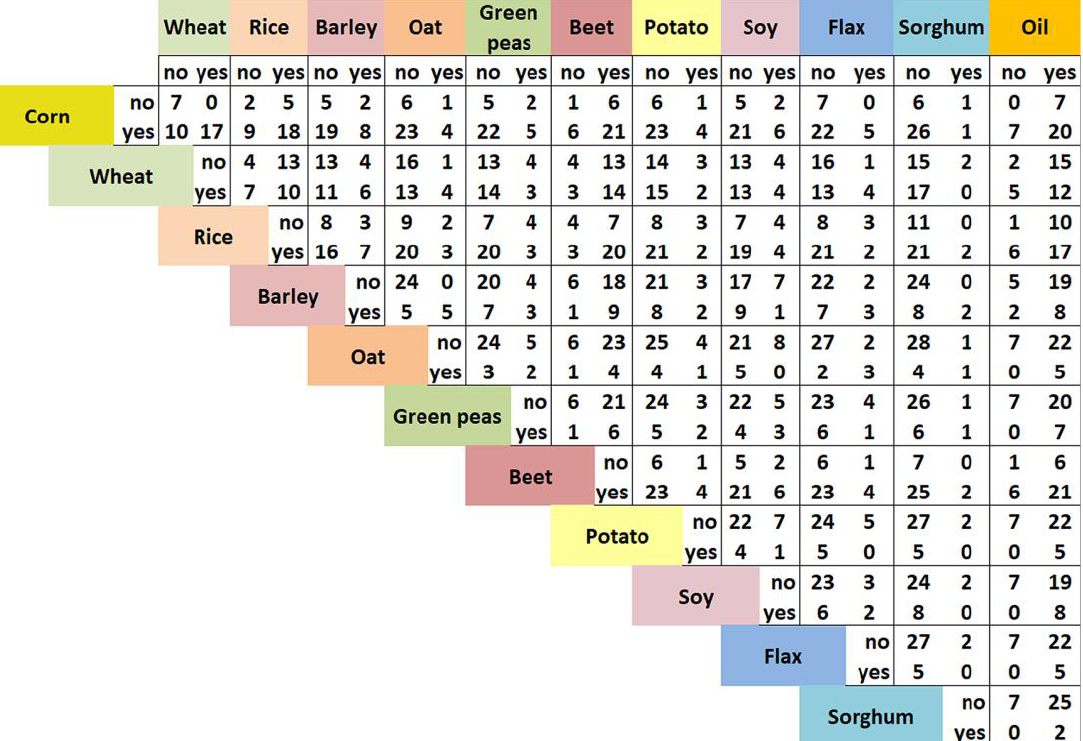
Figure 1. Two by two crosstabs of main ingredients in the composition of the analyzed samples (all diets and producers combined). The pairwise manner account for the presence of the ingredients’ source in the simultaneous presence (yes-yes), the presence of one source while the other is absent (yes-no or no-yes), and the concomitant absence (no-no).